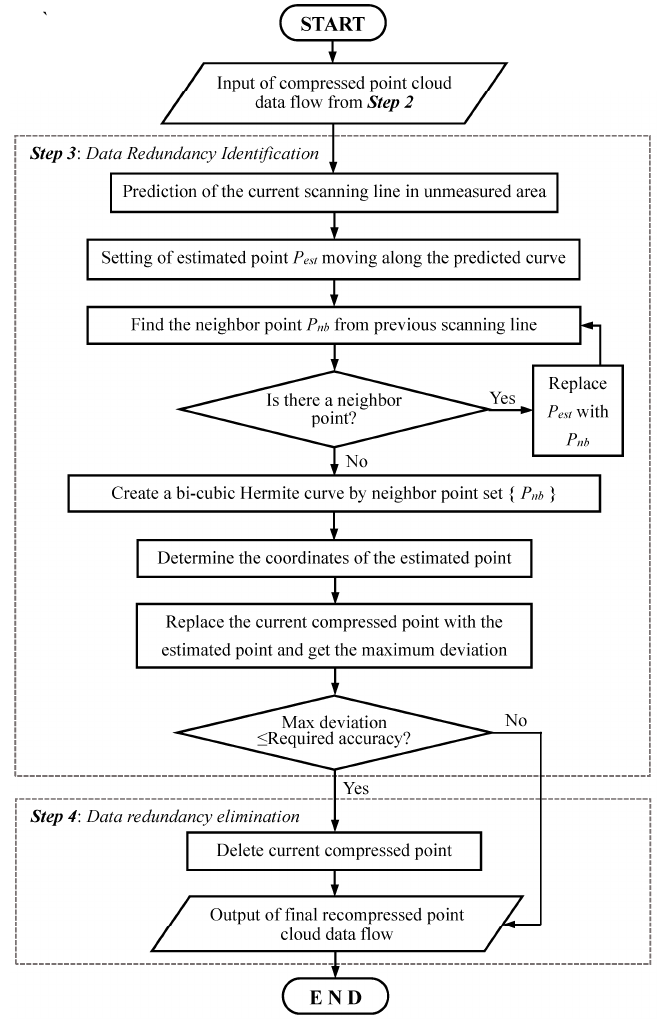
Figure 3. The flow chart of point cloud data redundancy identification and elimination algorithm.